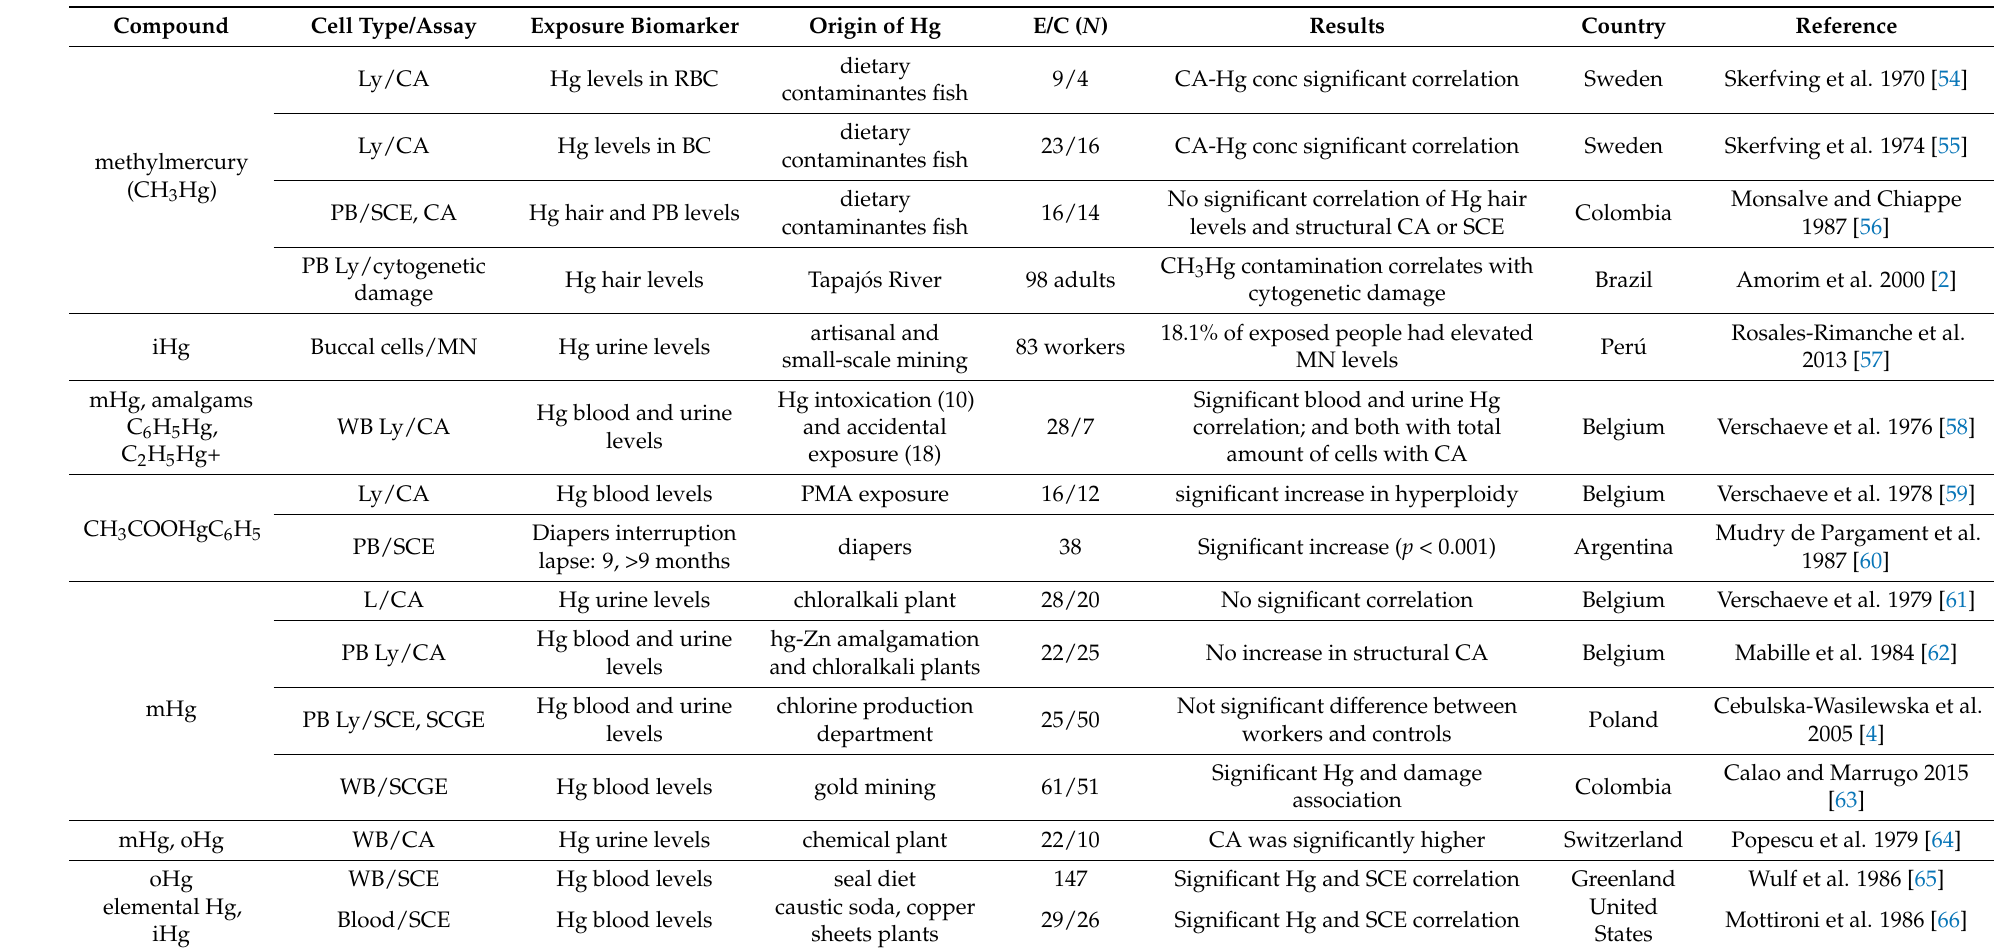
Table 3. Genotoxic effects in human populations exposed to Hg